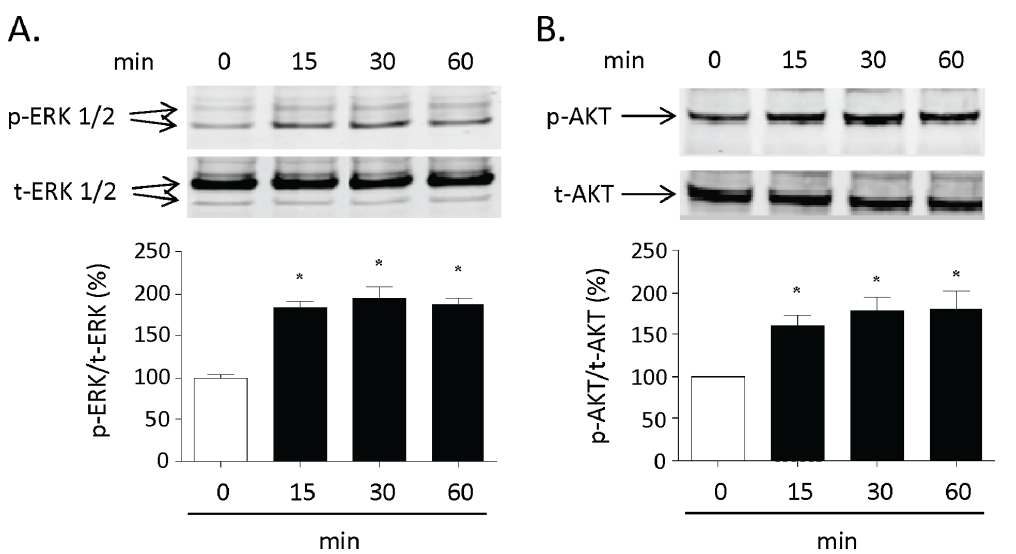
Figure 4. CPE activates ERK and AKT signaling pathways in primary cultured rat hippocampal neurons. Top panels: Representative Western blot analyses of hippocampal neuron lysates showing p-ERK 1/2 ( A ) and p-AKT ( B ) after 0, 15, 30 and 60 min treatment with 0.4 m M CPE. Total ERK (t-ERK 1/2) and total AKT (t-AKT) were also analyzed and served as internal controls. Bottom panels: Bar graphs showing the quantification of the p-ERK 1/2 ( A ) and p-AKT ( B ) signals normalized to t-ERK 1/2 and t-AKT, respectively. Note the increase in p-ERK and p-AKT after 15, 30 and 60 min treatment with CPE. Statistical analysis for A and B by one way ANOVA with Tukey post-hoc test, n=4, *p , 0.05 when compared to untreated control cells.